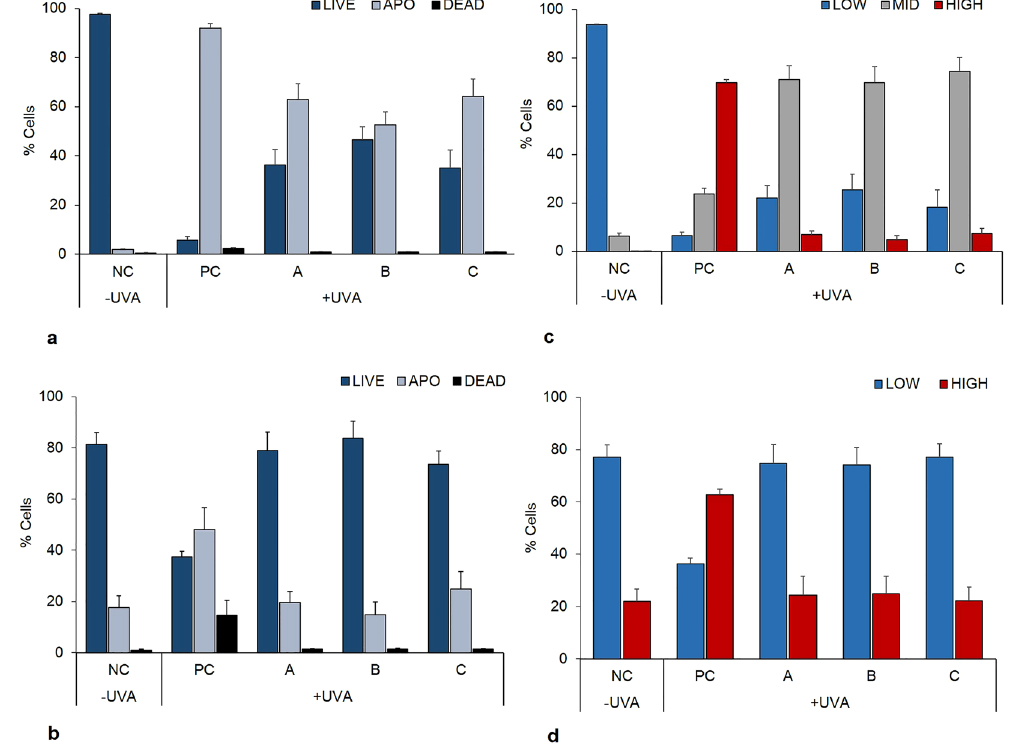
Figure 1. Viability of human dermal fibroblasts (HDF) and their intracellular levels of ROS after exposure to UVA (275 kJ m − 2 ). Cell viability, determined by using Guava Via-count dye straight after UVA exposure, time 0 (panel a); cell viability 24 h post-irradiation (panel b); ROS levels determined using carboxy-H 2 DCFDA probe straight after UVA exposure, time 0 (panel c); ROS levels 24 h post-irradiation (panel d). A, B and C indicate the different sunscreens used to screen HDF. A = European sunscreen, SPF 50 + ; B = USA sunscreen, SPF 50; C = Eco-friendly sunscreen, SPF 40. PC = positive control (HDF without sunscreens and exposed to UVA). NC = negative control (unexposed HDF). Error bars represent standard error (n =